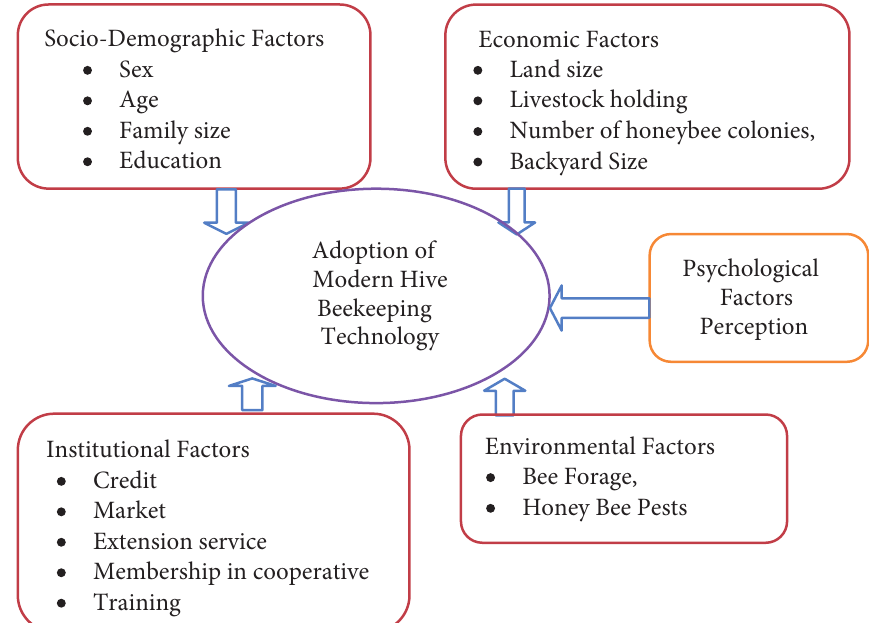
Figure 1: Conceptual framework of the study (source: on the basis of the available literature).